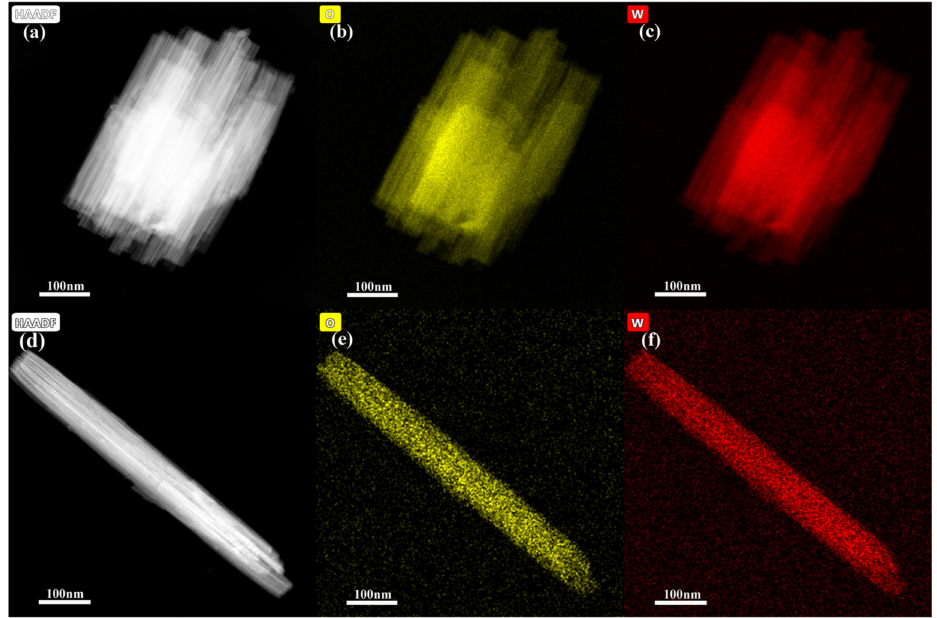
Figure 3. Elemental mapping images of the formed products with different initial reactants. ( a – c ) 1.4432 g Na 2 WO 4 2H 2 O, 30 mL 0.25 mol L − 1 H 2 SO 4 , ( d – f ) 1.4432 g Na 2 WO 4 2H 2 O, 20 mL 0.375 mol L − 1 H 2 SO 4 , and 10 mL